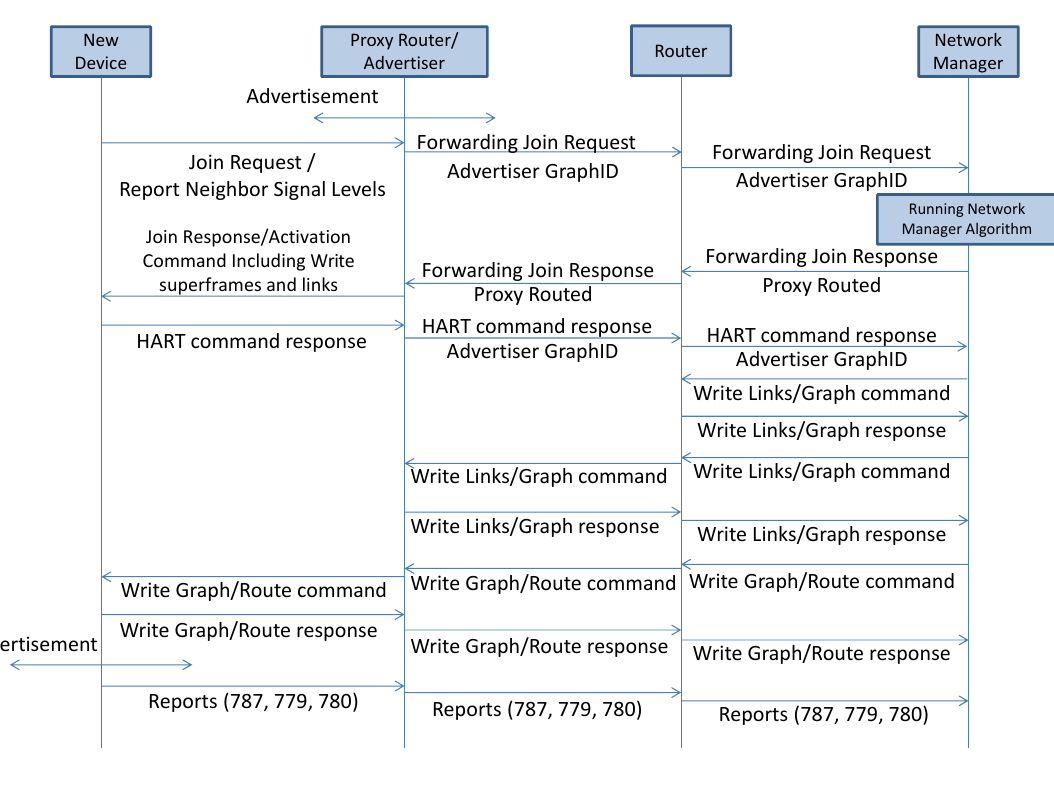
Figure 7. Joining